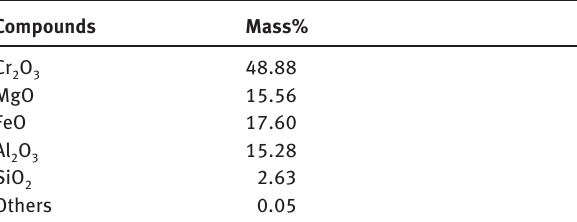
Fig. 2: The proposed process for production of Cr 2 O 3 from chromite concentrate